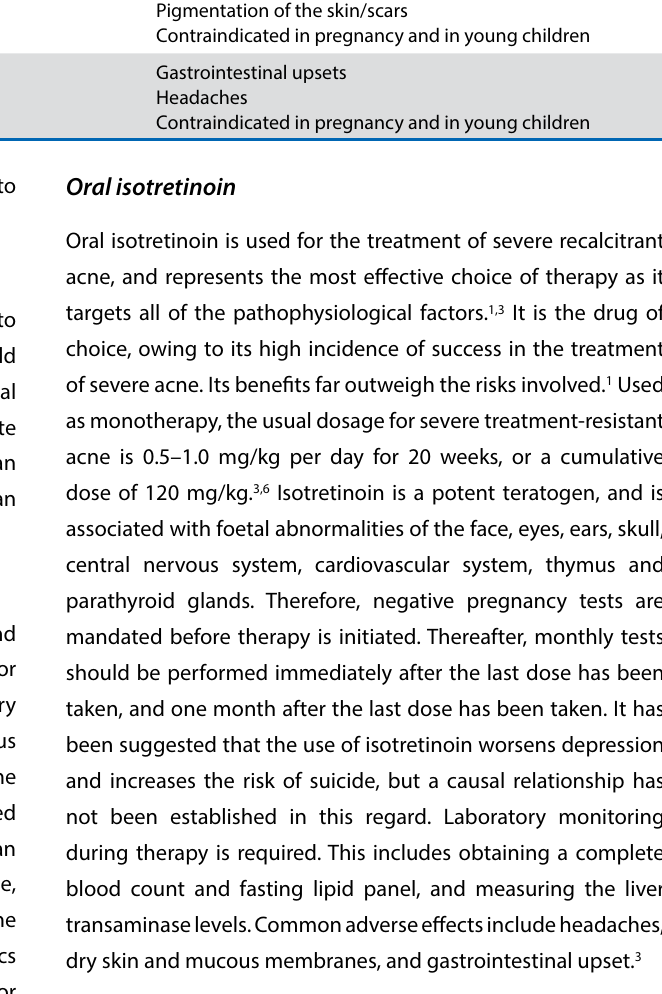
Drug Recommended dose Potential adverse